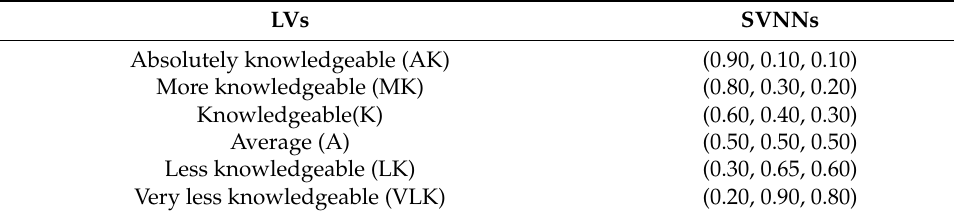
Table 3. Linguistic performance ratings of the DMs.